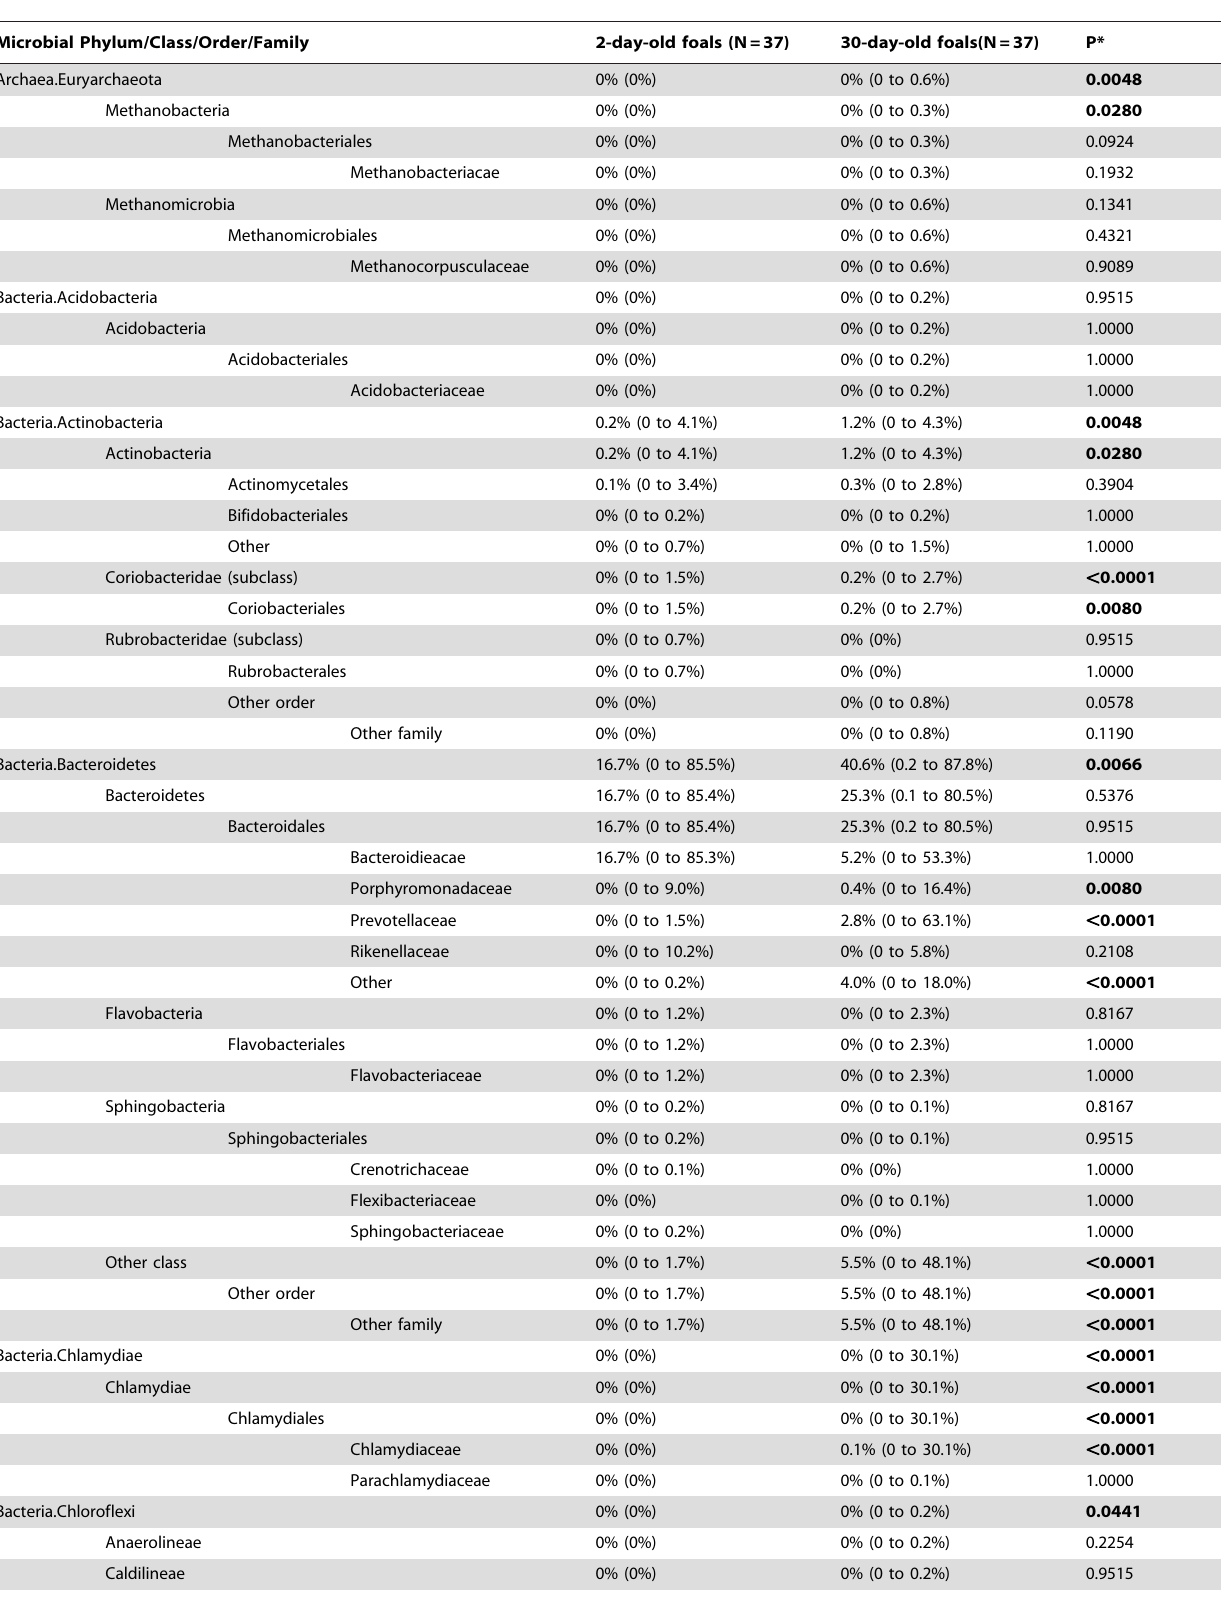
Table 2. Median and range percentages of sequences represented in the fecal DNA of rectal swab samples from foals (Phylum, class, order, and